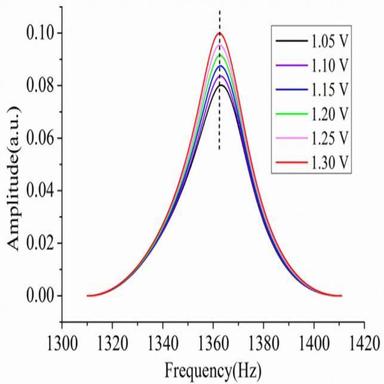
Resonant spectrum of an intact specimen with various excitation voltage.